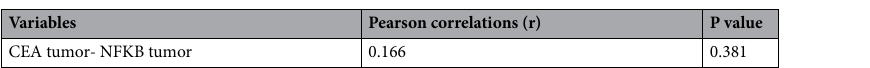
Variables Pearson correlations (r) P value CEA tumor- NFKB tumor 0.166 Table 3. Pearson correlation test between CEA and NFKB expression in cancer specimen.